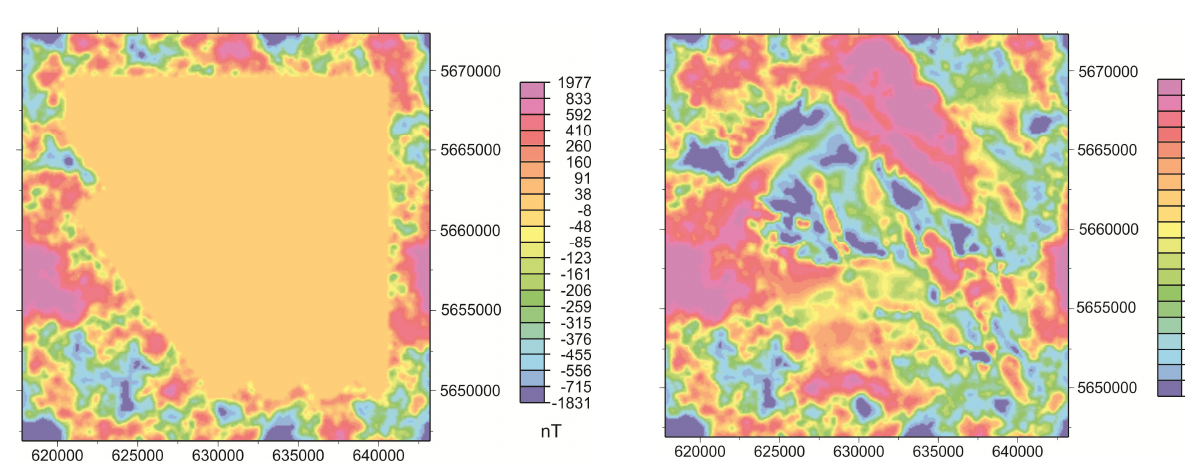
any discontinuities along the edges of the survey; for other